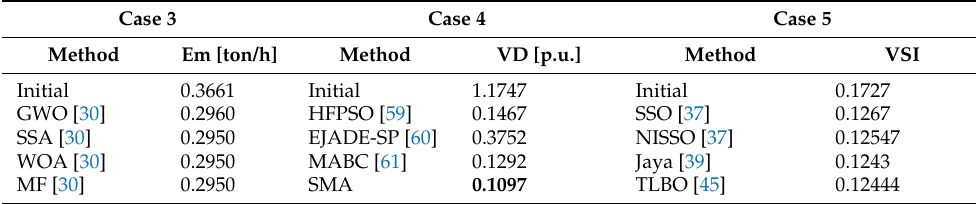
Table 5. Comparison of the results obtained by the SMA with other methods for Cases (3, 4, and